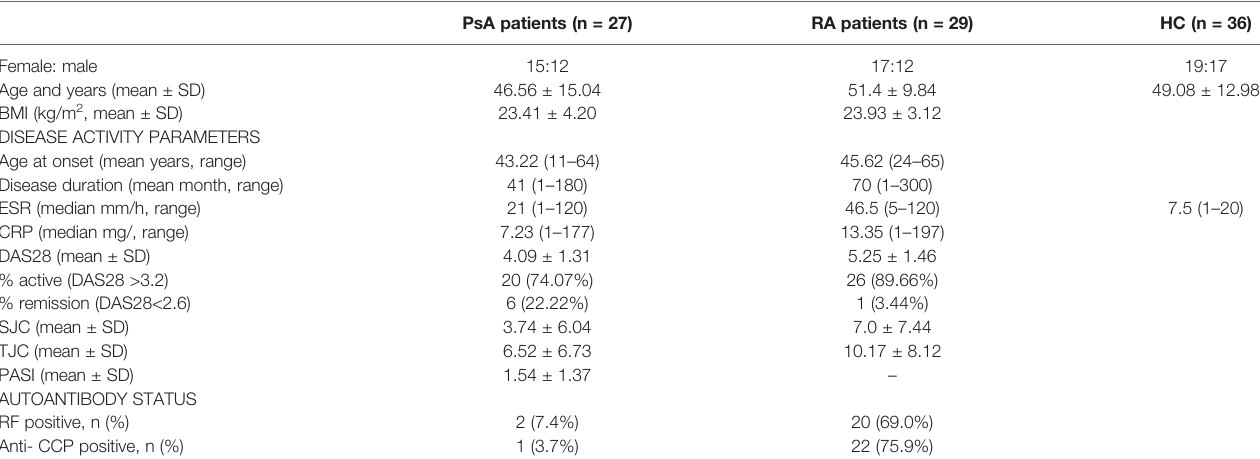
TABLE 1 | Demographics and clinical characteristics of PsA and RA patients and health control a